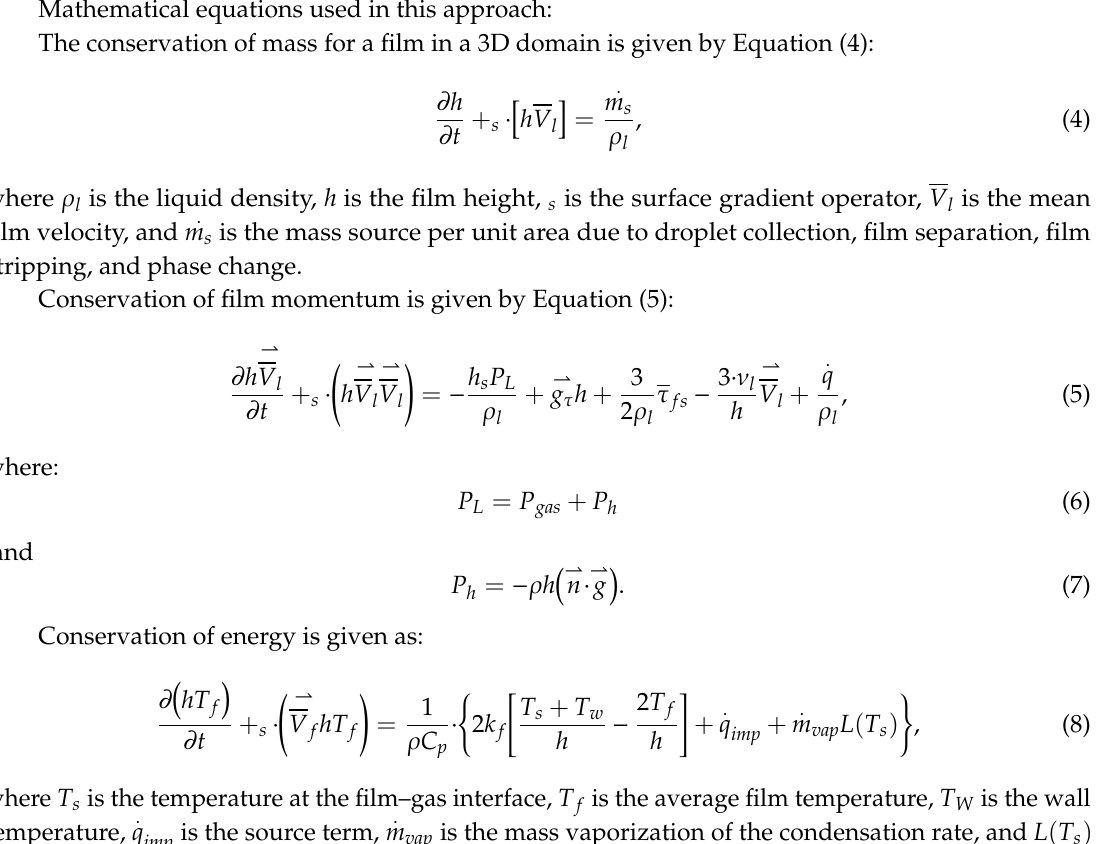
Figure 7. Evaporation of thin water film on the front glass.